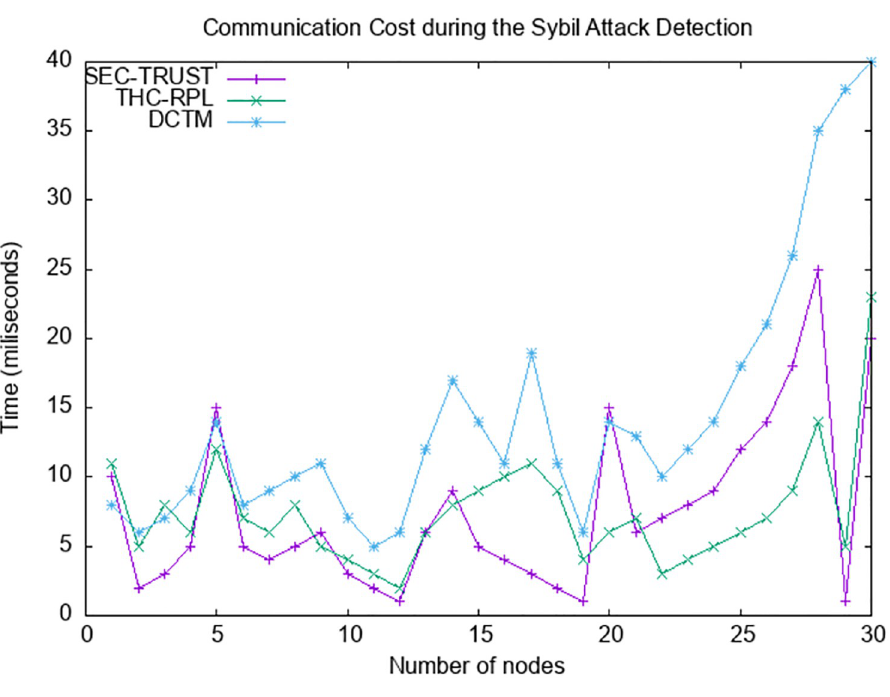
Fig 18. Communication